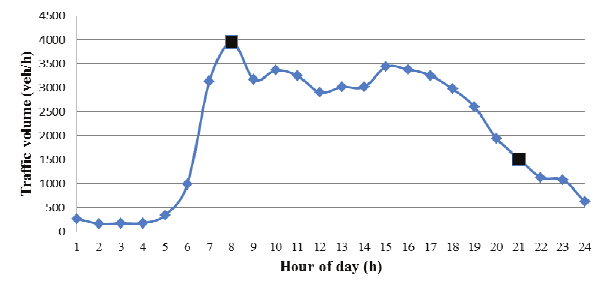
Fig. 2. Aggregate daily traffic volume for selected roundabout at the day of research (black squares means selected part of the day)